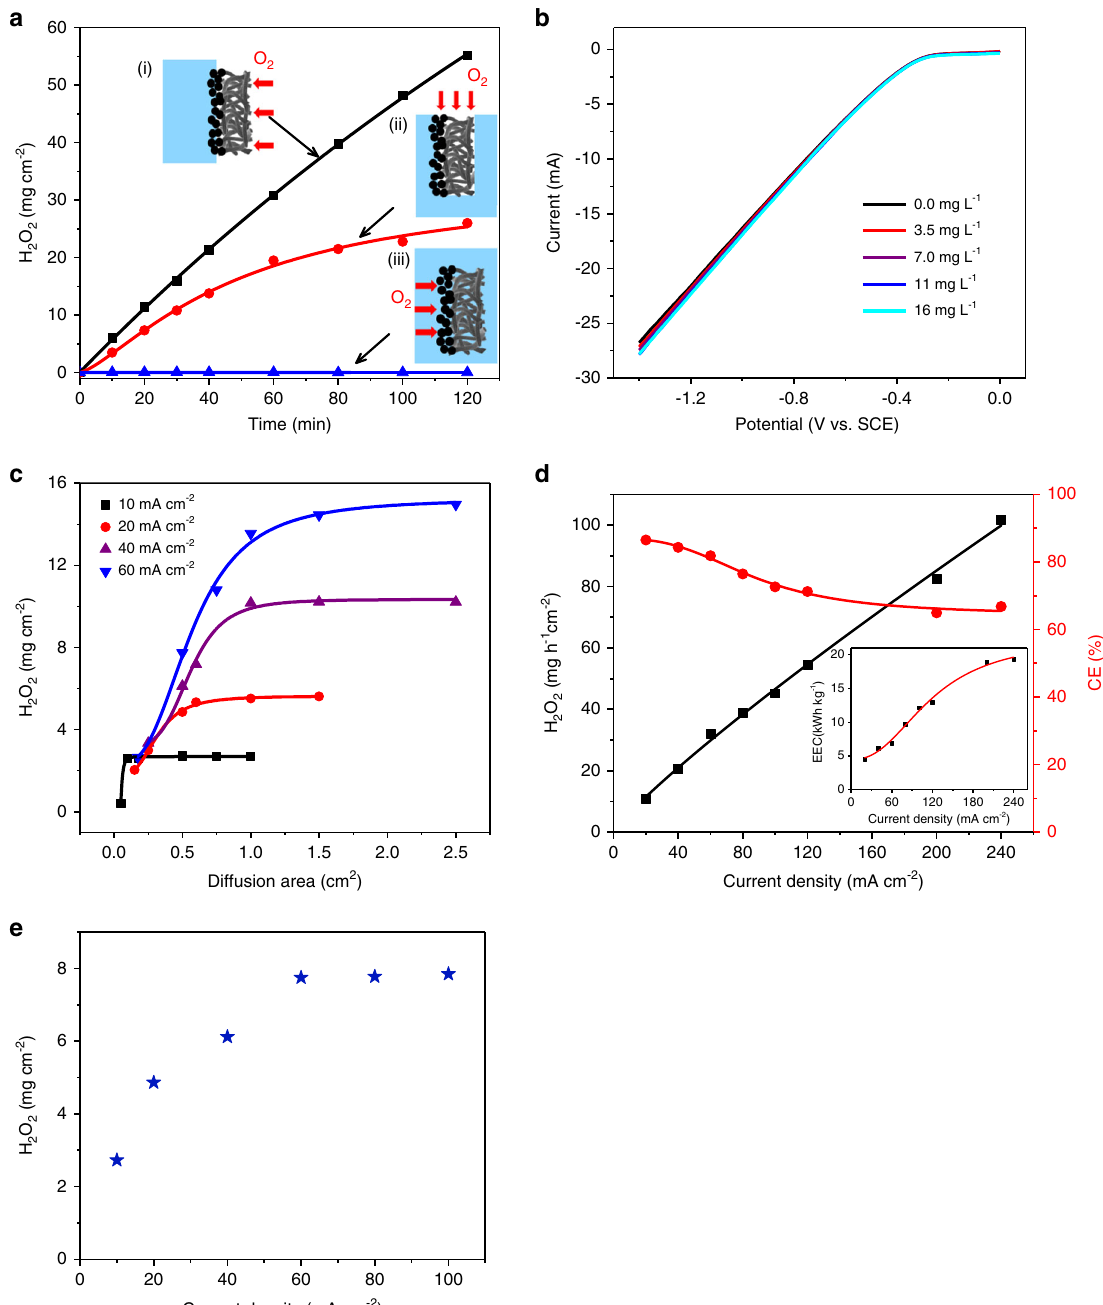
Fig. 4 Oxygen mass transfer and electron transport in the ORR. a The concentration of H 2 O 2 production by different systems at 60 mA cm − 2 current density. b LSVs of NADE in Na 2 SO 4 solution with different oxygen concentrations. c The concentration of H 2 O 2 production (0.5 h) with the change in oxygen diffusion area under different current densities. d The yield of H 2 O 2 and the corresponding current ef fi ciency under different current densities; the inset shows the corresponding energy consumption at different current densities. e Production of H 2 O 2 under different current densities with the diffusion area of 0.5 cm 2 . Source data are provided as a Source Data fi